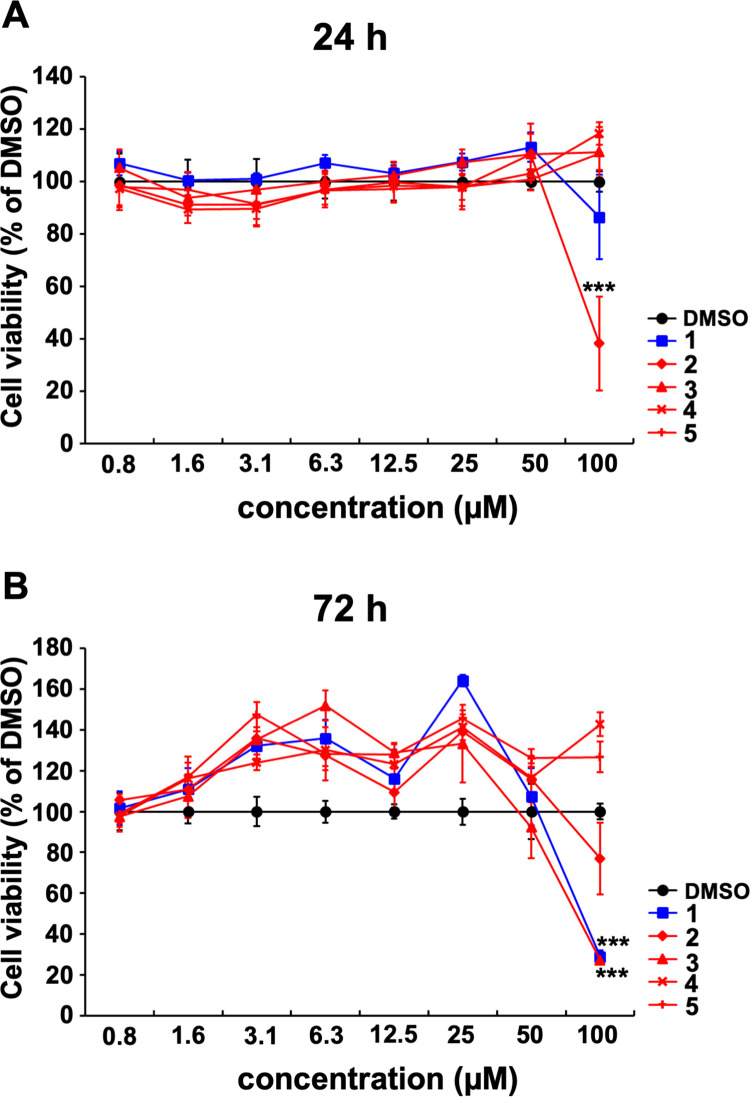
Toxicity of cyclobakuchiols A–D against MDCK cells.The indicated concentrations of cyclobakuchiols A (2), B (3), C (4), and D (5) or (+)-(S)-bakuchiol (1) in DMSO (concentrations of 100 μM, 1%; 50 μM, 0.5%; 25 μM, 0.25%; 12.5 μM, 0.125%; 6.3 μM, 0.063%; 3.1 μM, 0.031%; 1.6 μM, 0.016%; 0.8 μM, 0.008%) were added to the MDCK cells. Cell viabilities were determined by MTT assay after incubation for 24 h (n = 5 each) (A) or 72 h (n = 5 each) (B). Data represent the mean ± SEM and were representative of three independent experiments. ***p < 0.001, for the comparison with DMSO-treatment. The results were reproducible in this experiment.